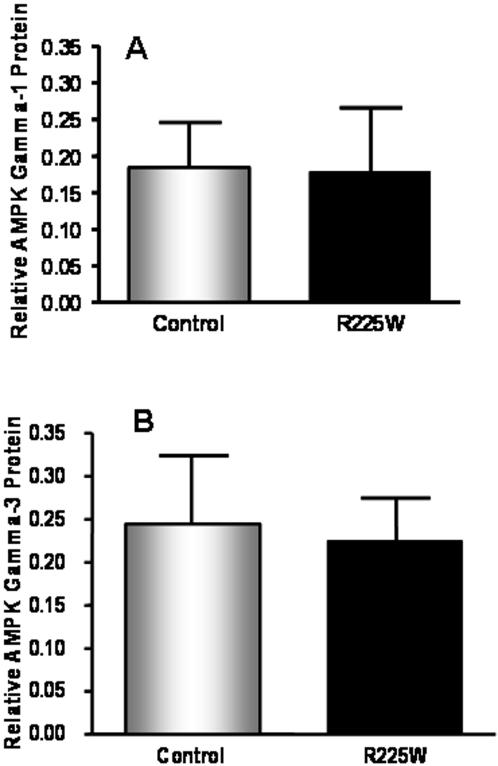
Relative protein levels of the γ1 (A) and γ3 (B) isoforms in differentiated skeletal muscle cells from R225W carriers and matched control subjects.The integrated densitometry value (IDV) for each γ subunit was divided by the IDV of the loading control, β-actin. Means +/− SD. n = 2–4, Student's t-test, p = 0.389 (A), p = 0.229 (B).